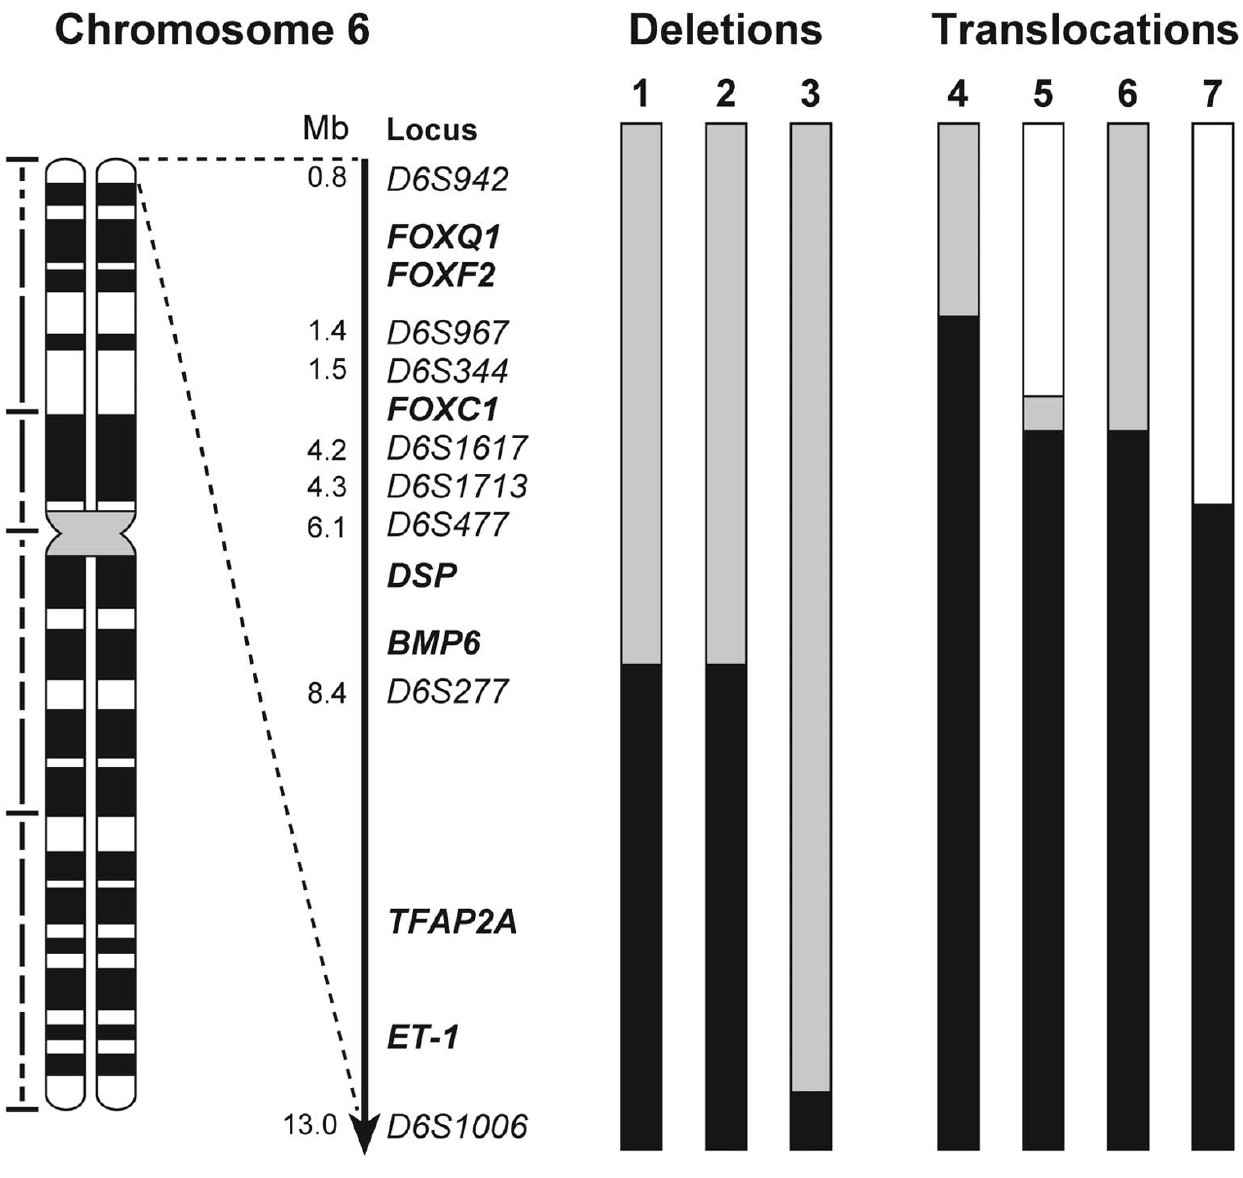
Schematic diagram of the distal tip of human chromosome 6p. The black boxes indicate regions where the patients are not deleted. White boxes indicate the minimum extent of the deletion. Grey boxes indicate the maximum extent of the deletion. Markers used are listed to the left of the patients chromosomes under locus. Genes in this region are listed in bold print. The genetic distance of markers, in Mb (megabases) from the telomere, are also